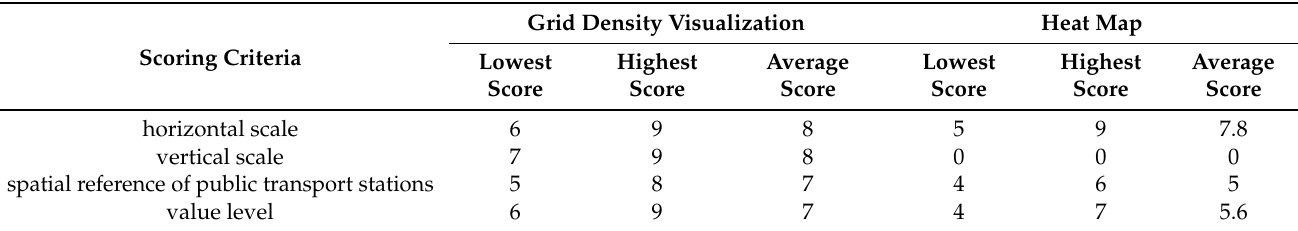
Table 1. Comparison between Grid density visualization and Heat Map.